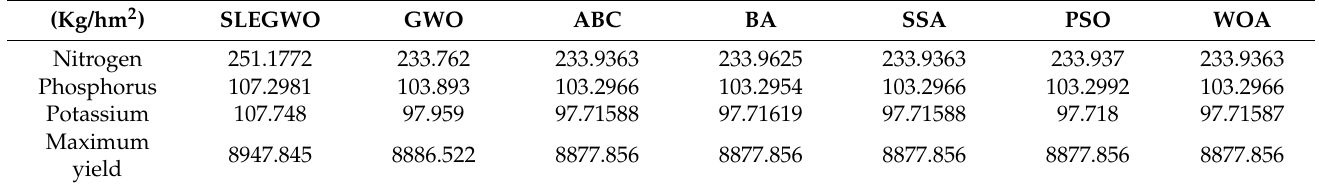
Table 7. Nitrogen, phosphorus, potassium fertilizer, and the corresponding maximum yield of different models. (Kg/hm 2 ) SLEGWO GWO ABC BA SSA